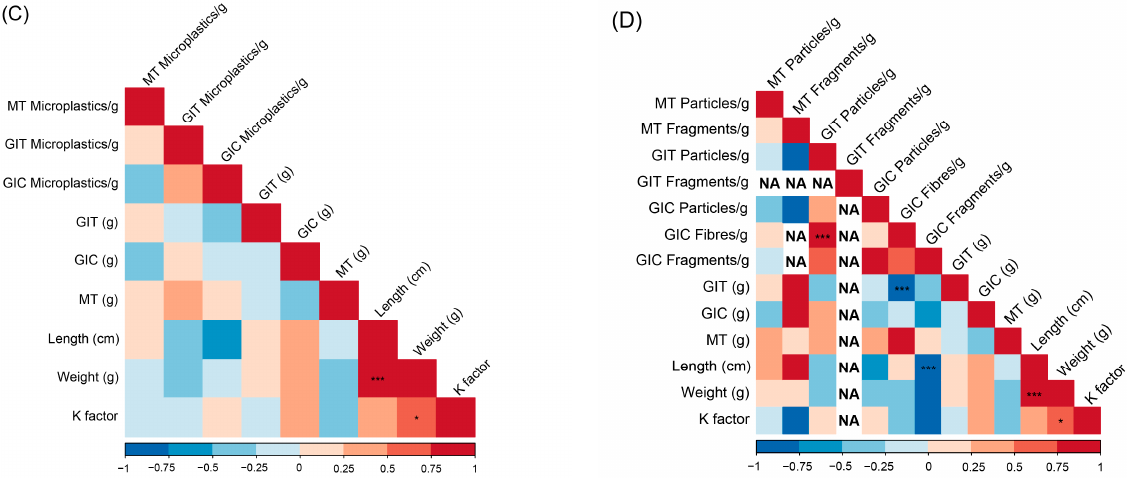
Figure 3. Spearman’s rank-order correlograms highlighting the microplastic correlations. Positive (1) and negative (–1) correlations are represented with color gradients, while the p values are represented with asterisks (*** p < 0.001, * p < 0.05). NA represents situations where there were not enough values to compute the correlation; gastrointestinal tissue (GIT), gastrointestinal content (GIC) and muscle tissue (MT). Subfigure ( A )—total microplastics found, subfigure ( B )—total microplastics found by type, subfigure ( C )—microplastics/g, subfigure ( D )—microplastics/g by type. The Feret diameter of the analyzed particles is presented in Table 4. It is clear that the highest Feret diameter is for a microplastic in the shape of a fi ber, while the lowest is found for a microplastic in the shape of a particle. There appears to be no barrier for par- ticles and fragments when related to their dimension, while for fi bers, it is clear from their absence that not even the smallest ones are not being transported from the GIC to the organism. Table 4. The Feret diameter of the analyzed microplastics; gastrointestinal tissue (GIT), gastroin- testinal content (GIC), and muscle tissue (MT).